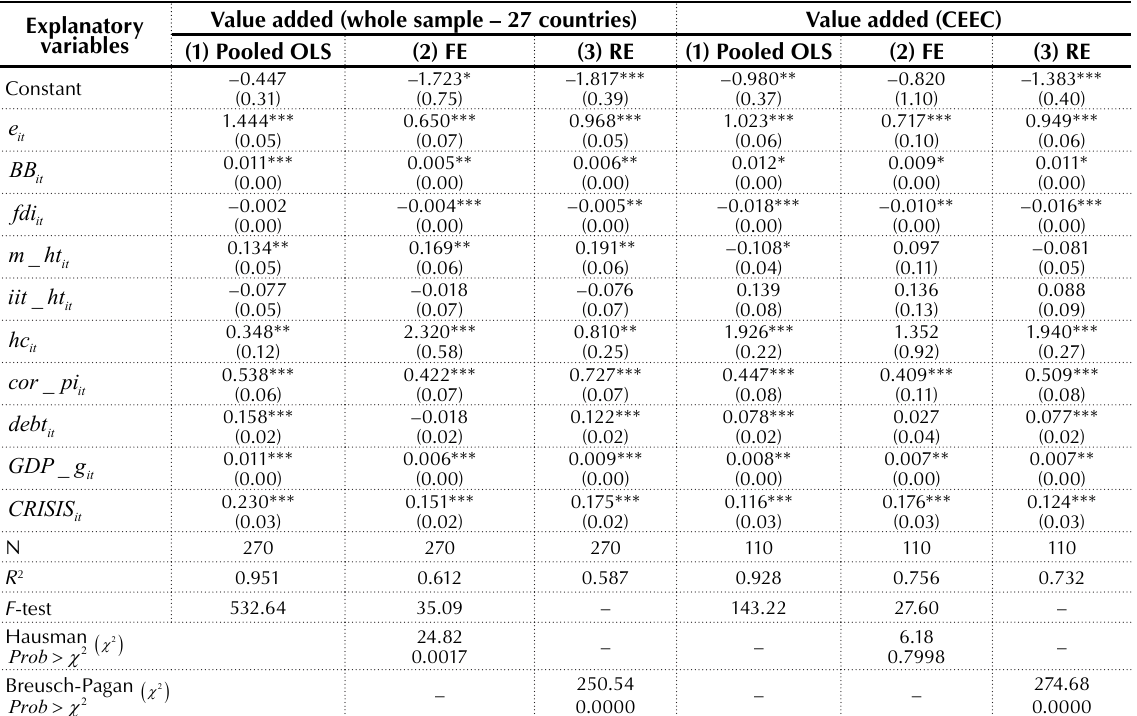
Table 5a. Value added determinants: the whole sample and CEE countries Source: Authors’ calculations based on data from the sources mentioned in Table 2.